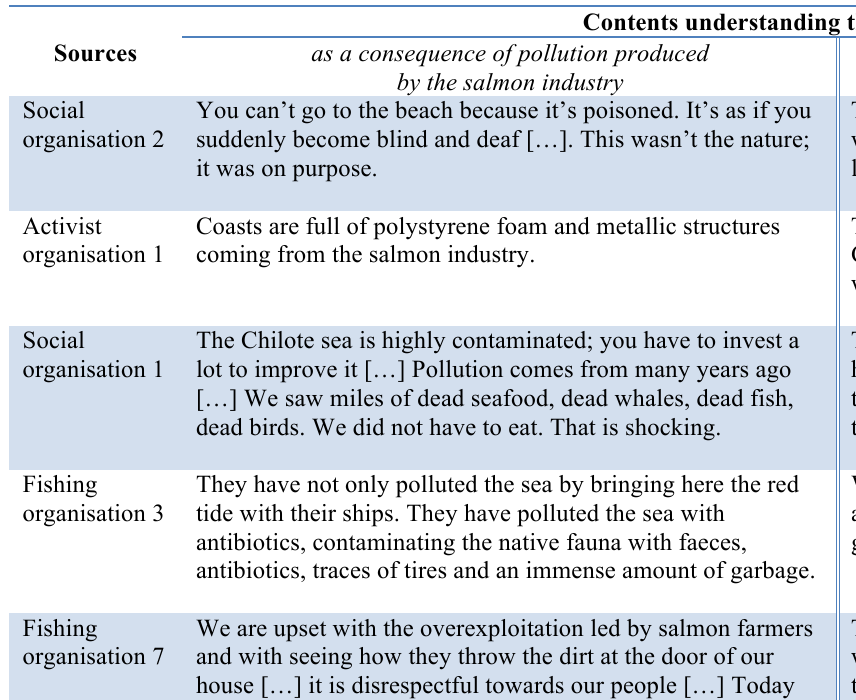
Table A2.1 Controversial sentences from in-depth interviews on the topic ‘poisoning of waters’ (including selected material from key